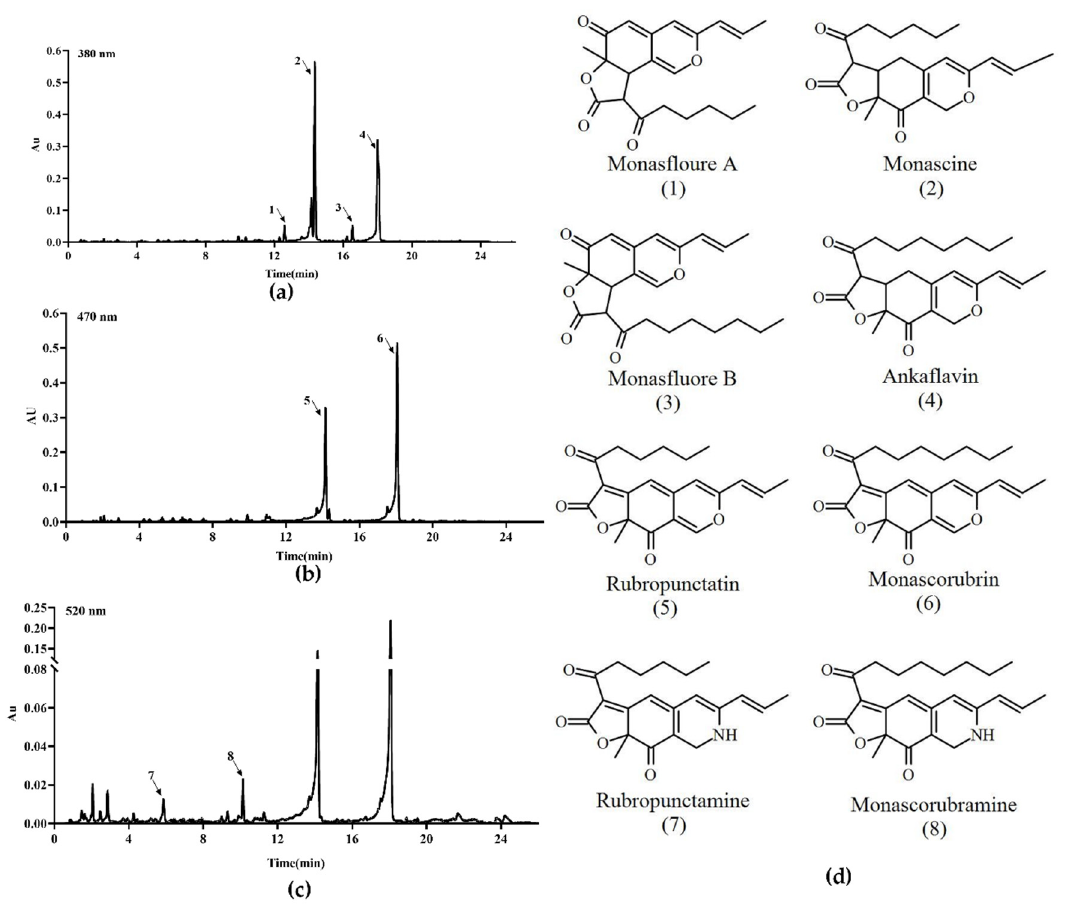
Figure 6. The main pigments of M. ruber M7 detected by UPLC. ( a ) The chromatogram of 4 main yellow pigments at 380 nm, which are indicated by 1, 2, 3 and 4. ( b ) The chromatogram of 2 main orange pigments at 470 nm, which are indicated by 5 and 6. ( c ) The chromatogram of the 2 main red pigments at 520 nm, which are indicated by 7 and 8. ( d ) The chemical structure formula of the 8